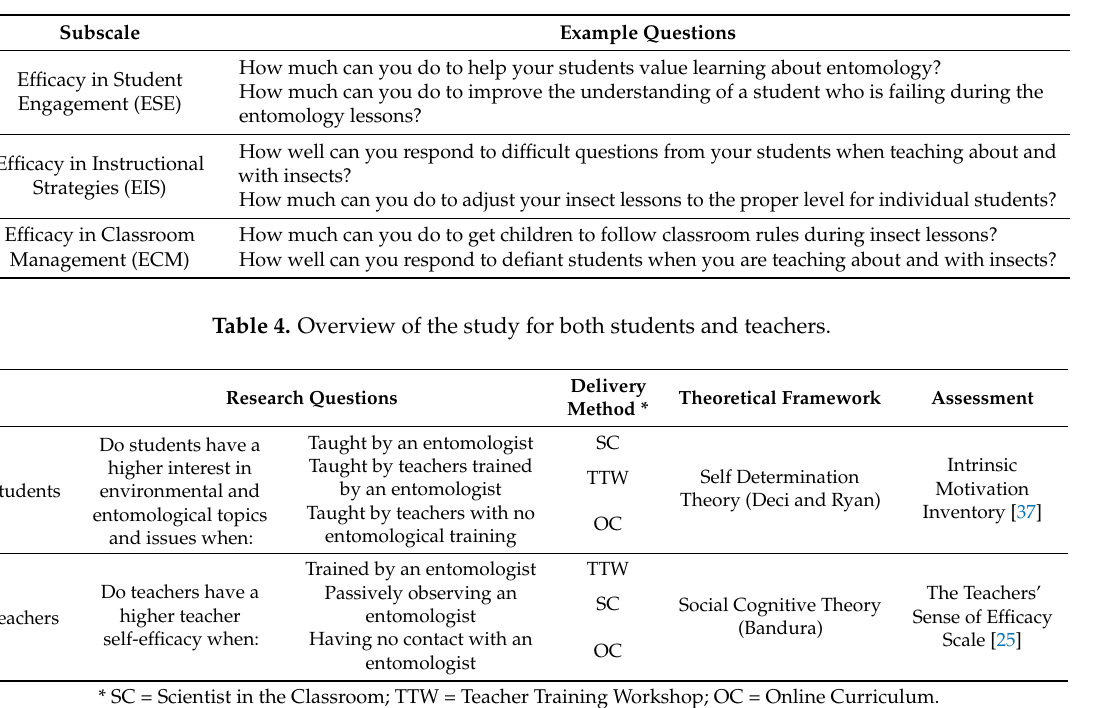
Table 3. Sample questions from The Teachers’ Sense of Efficacy Scale [25], modified for the environmental and entomological lessons.